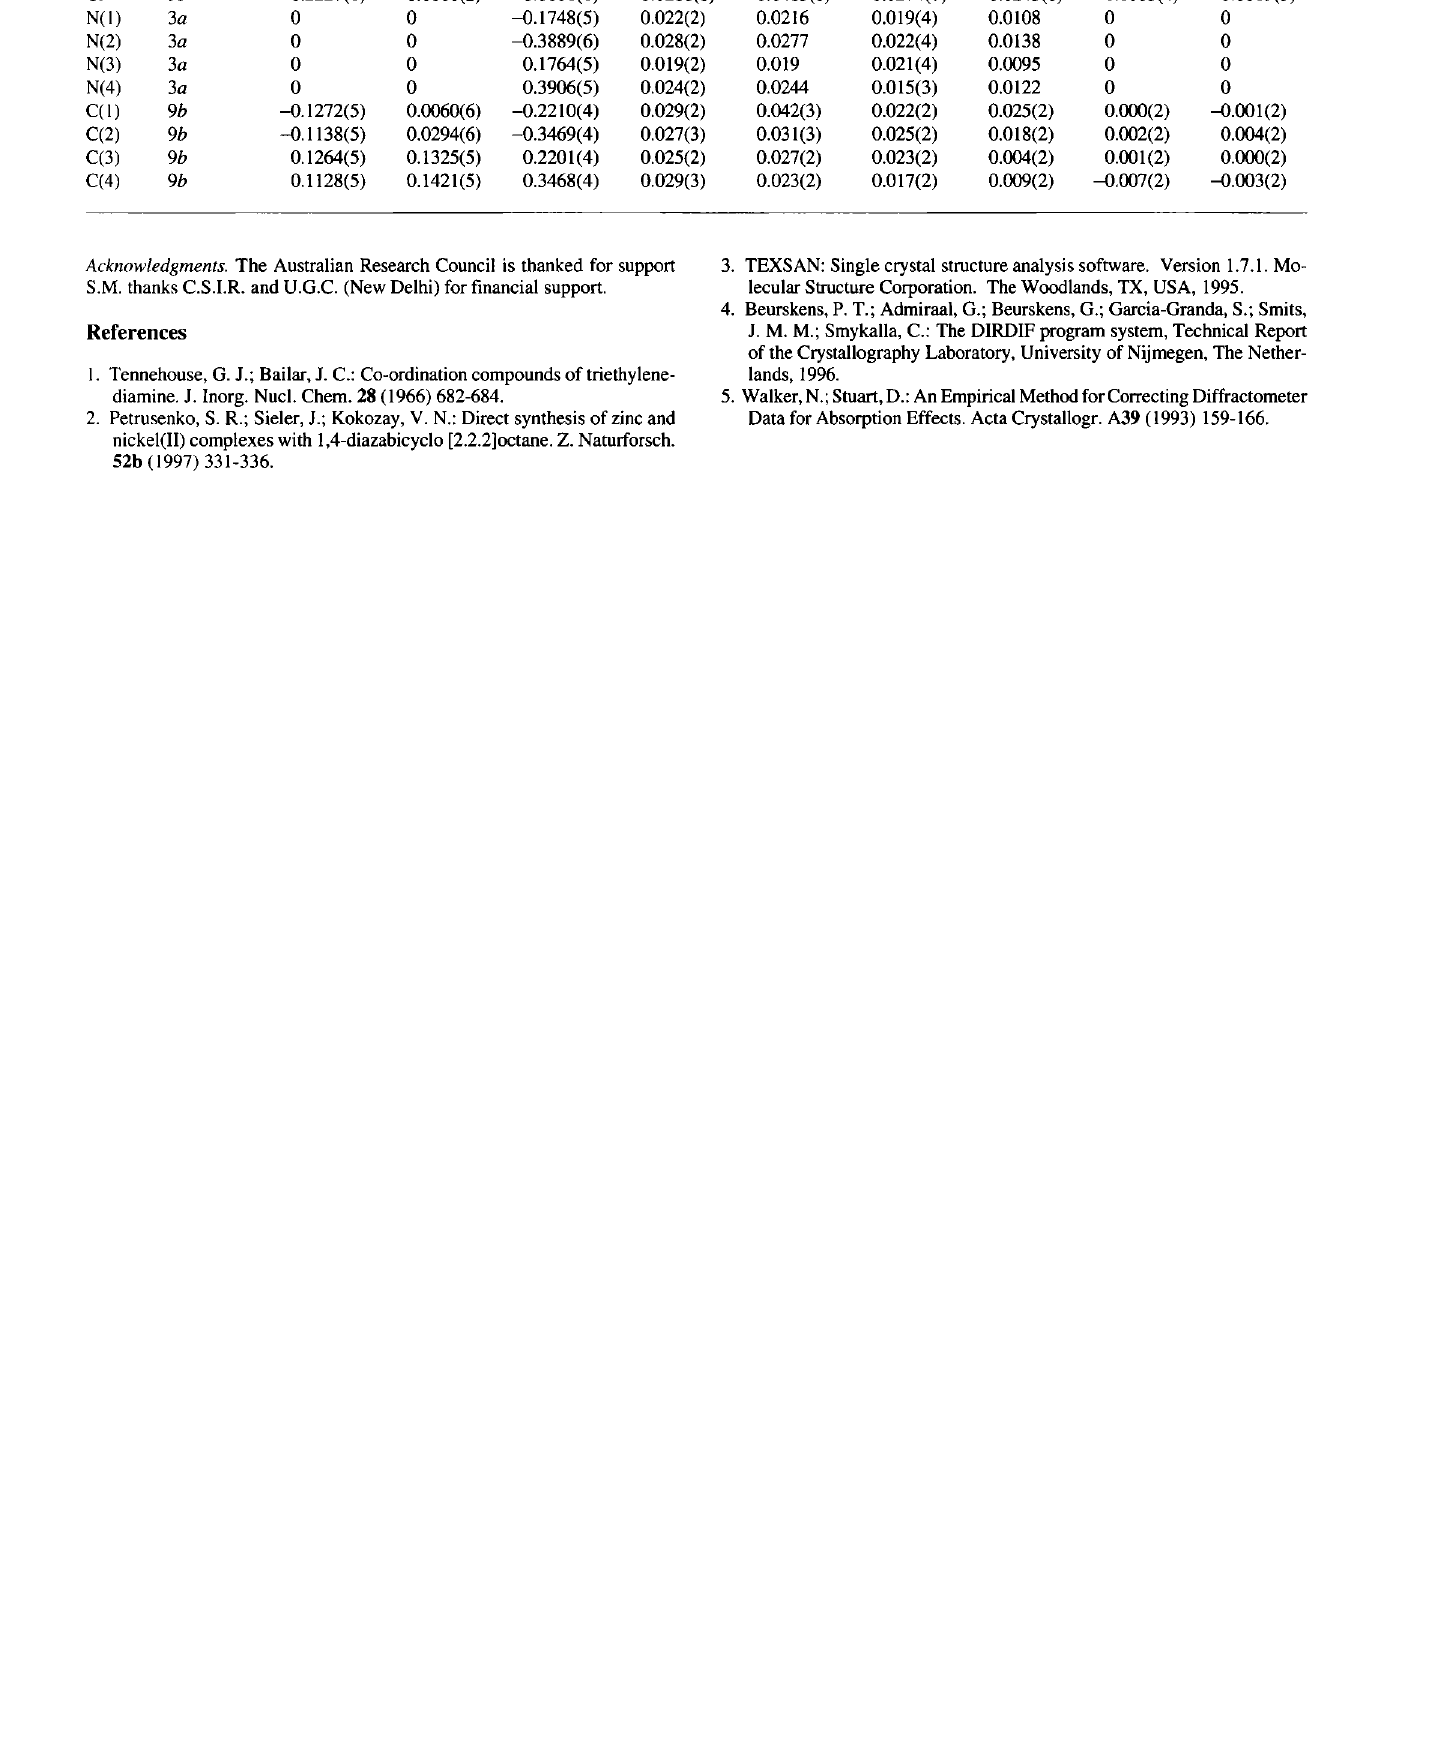
Table 3. Atomic coordinates and displacement parameters (in Ä 2